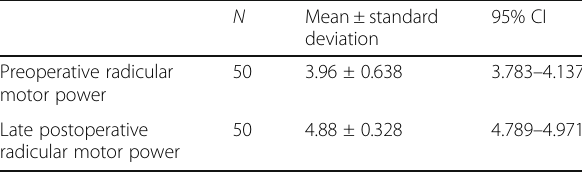
Table 2 Comparison between different values of VAS for axial Table 4 Comparison between preoperative and late neck pain postoperative values of radicular motor Min Max Mean ± Std 95% CI p value Dev Preoperative VAS for axial neck pain vs early postoperative VAS for axial neck pain